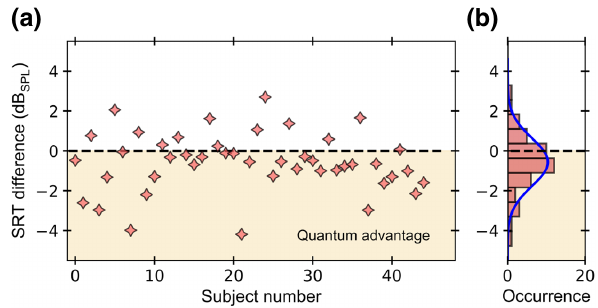
FIG. 4. The results of the speech-recognition test on n = 45 individuals. (a) Each individual’s difference in SRT for speech snippets recorded with the classical and quantum microphone, respectively. The data below the dashed line represent a quantum improvement. (b) The histogram of all data points. The quan- tum microphone reduces the volume level required to achieve the SRT by − 0.57 dB SPL , with a 95% confidence interval of ± 0.44 dB SPL